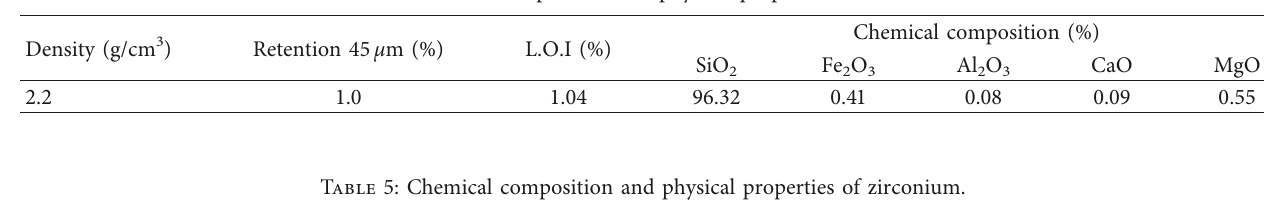
Table 4: Chemical composition and physical properties of silica fume.